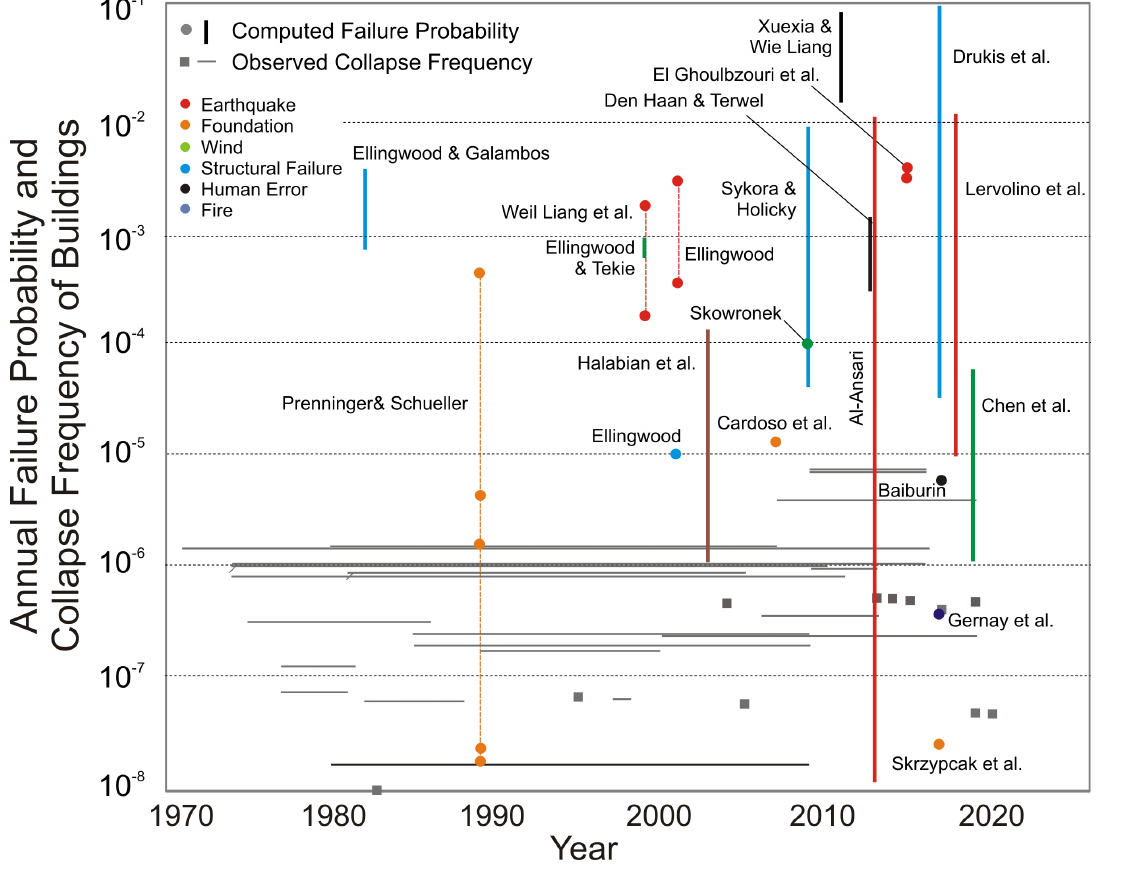
Figure 3. Computed probabilities of failure for buildings based on various references given in Table 1 and related to actions.